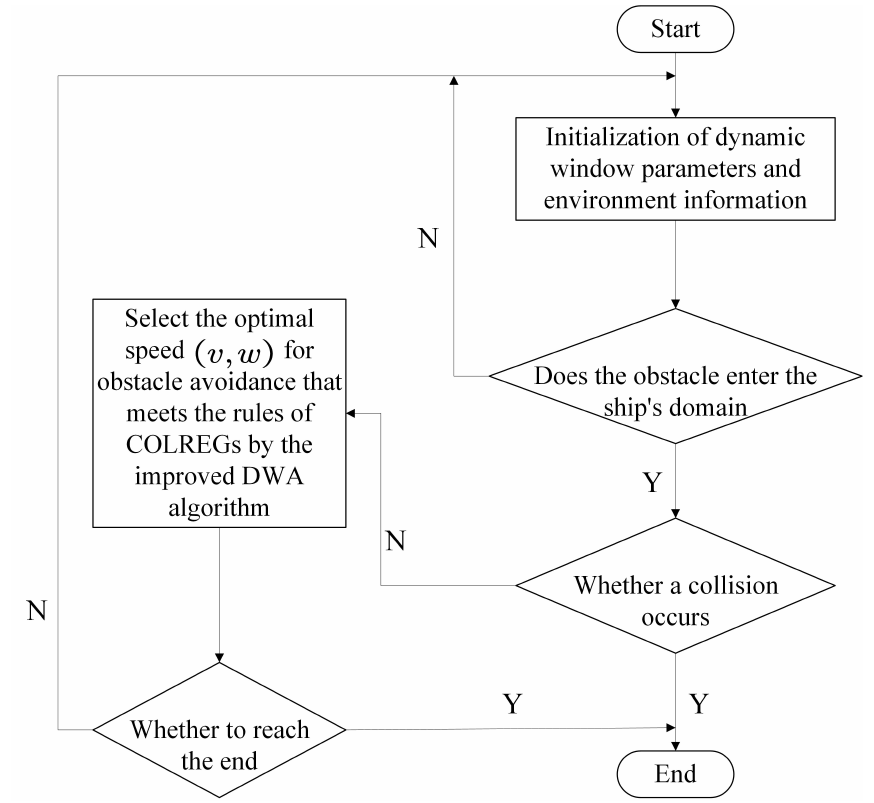
Figure 9. Collision avoidance algorithm flow